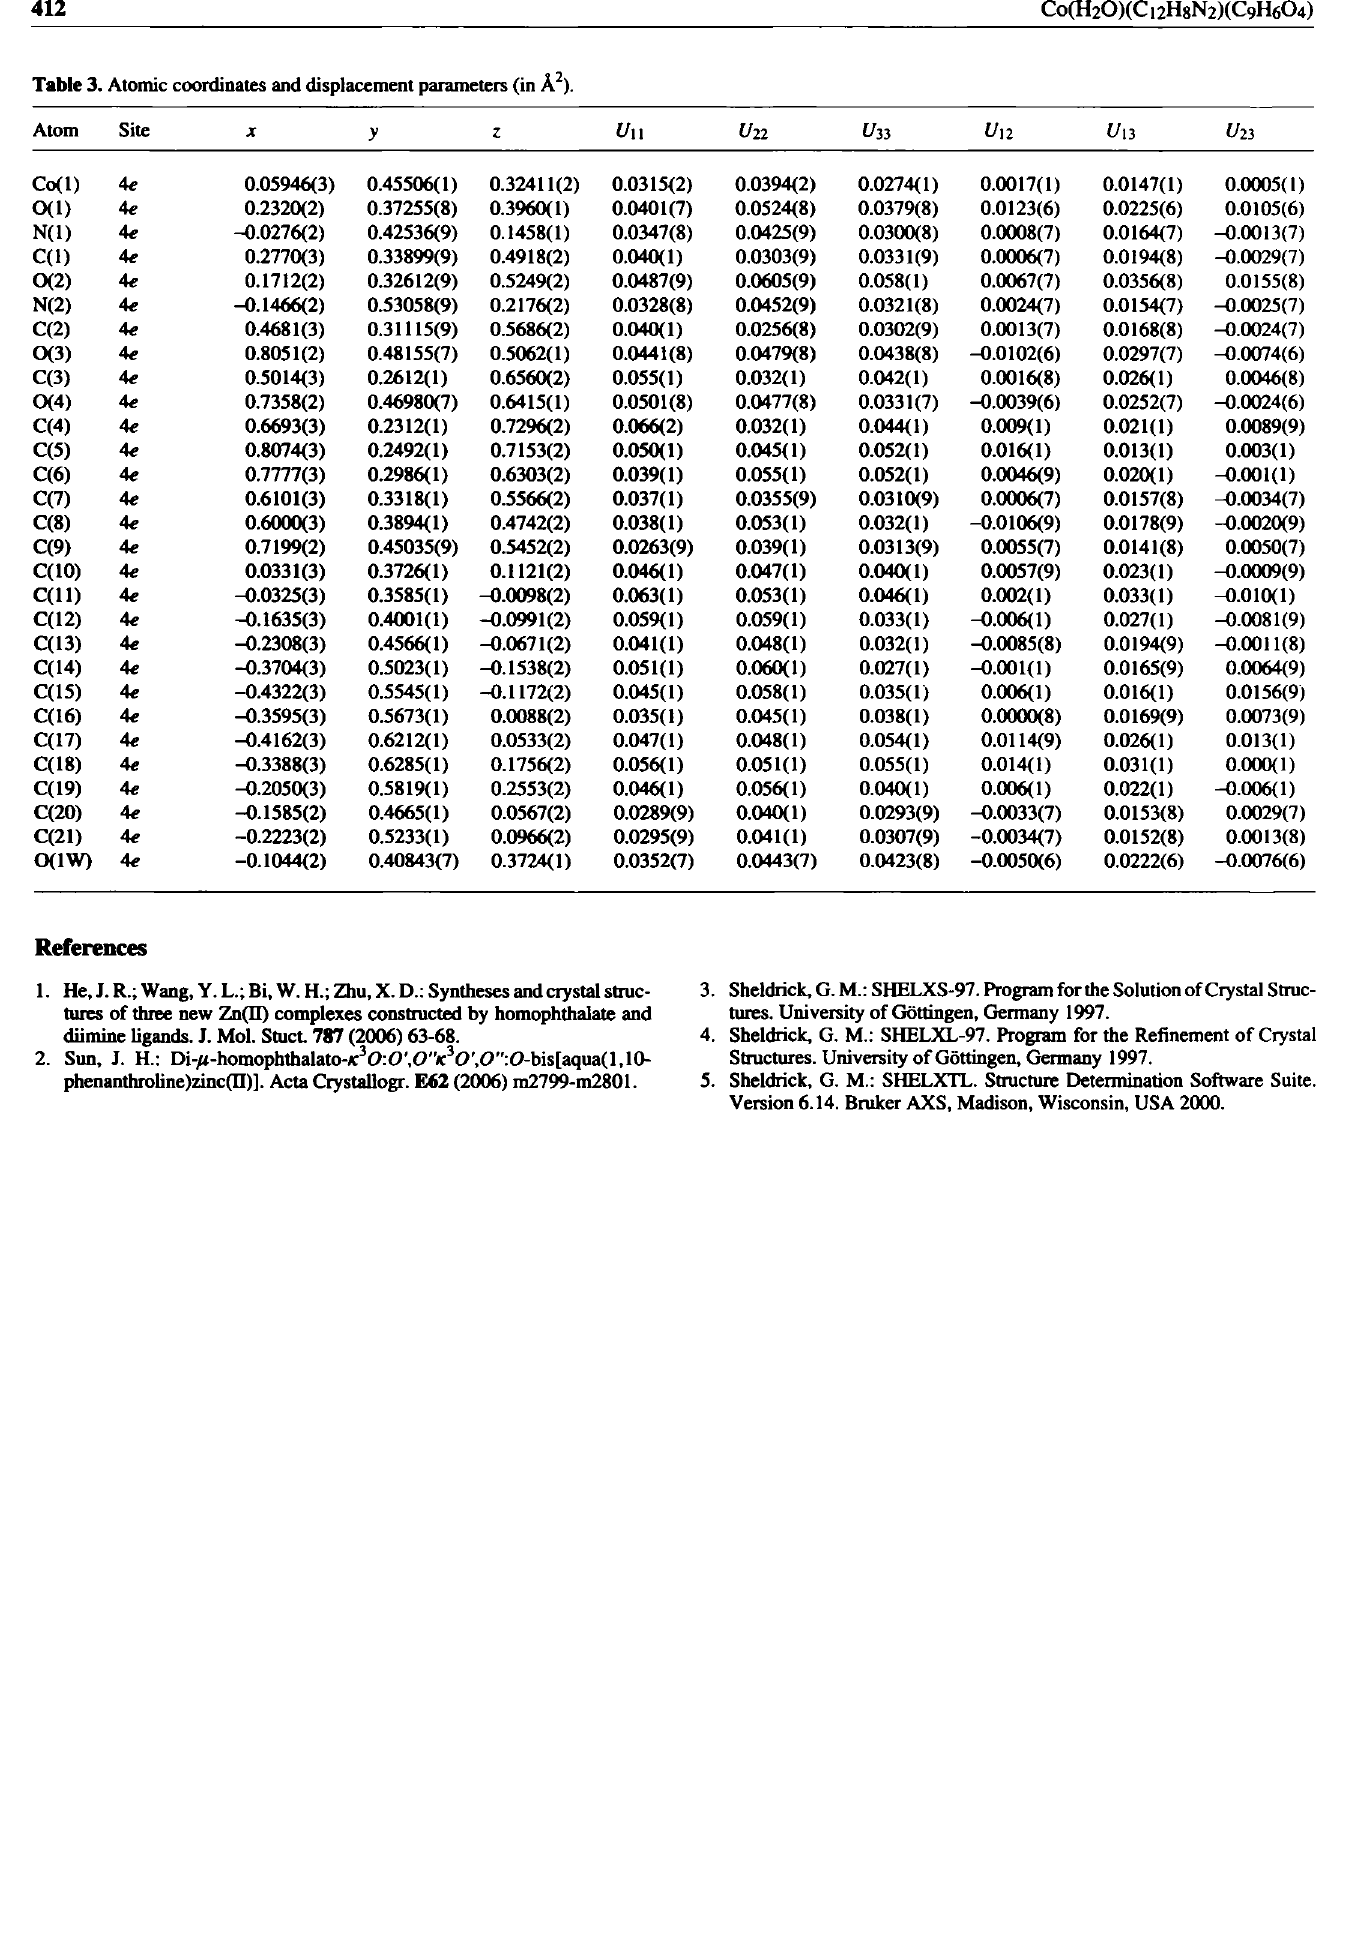
Table 3. Atomic coordinates and displacement parameters (in Â 2